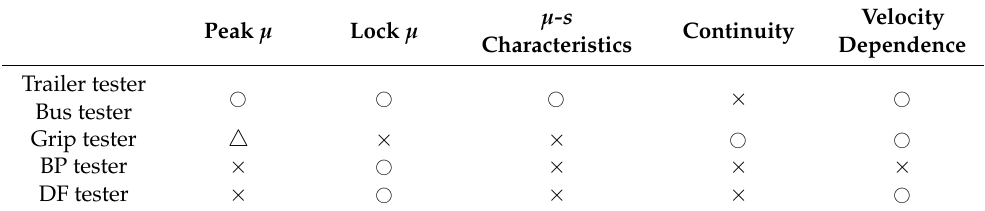
Table 1. Features of the measurement system.